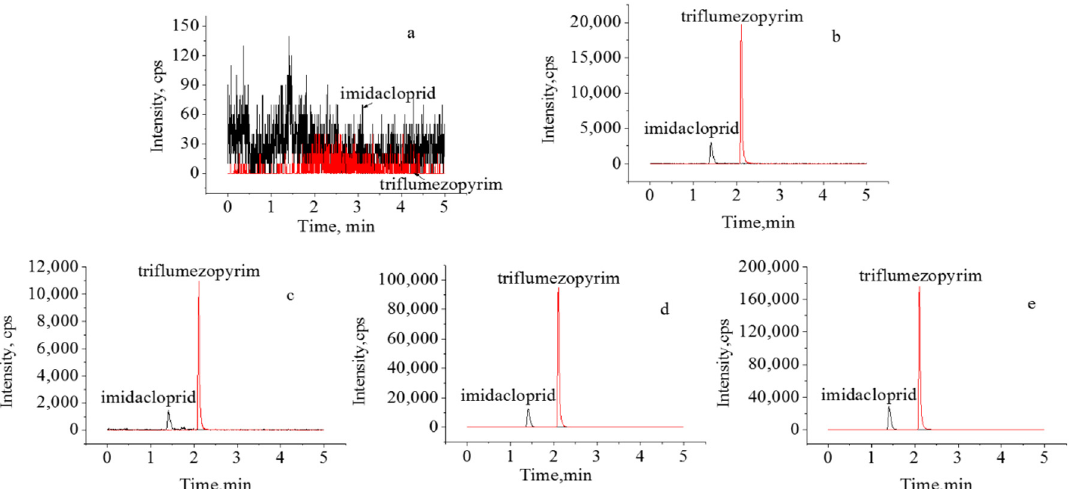
Figure 4. Typical LC-MS/MS chromatograms of triflumezopyrim and imidacloprid. ( a ) blank sample, (b) standard, (c) recovery at 0.01 mg/kg, (d) recovery at 0.1 mg/kg, (e) recovery at 0.2 mg/kg.